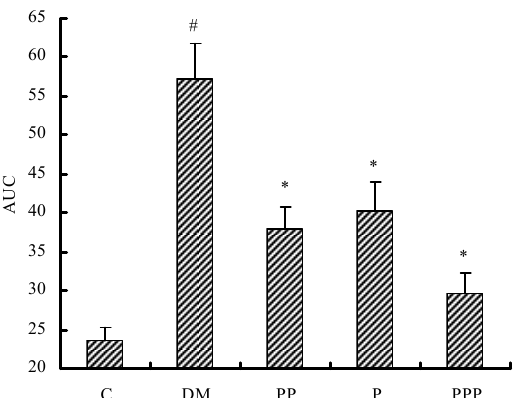
Figure 6. The effect of pumpkin polysaccharides and puerarin on the AUC of glucose tolerance ( n = 10). C, control; DM, diabetic model; PP, pumpkin polysaccharides; P, puerarin; PPP, pumpkin polysaccharides and puerarin. # p < 0.05 compared with the C group; * p < 0.05 compared with the DM group.